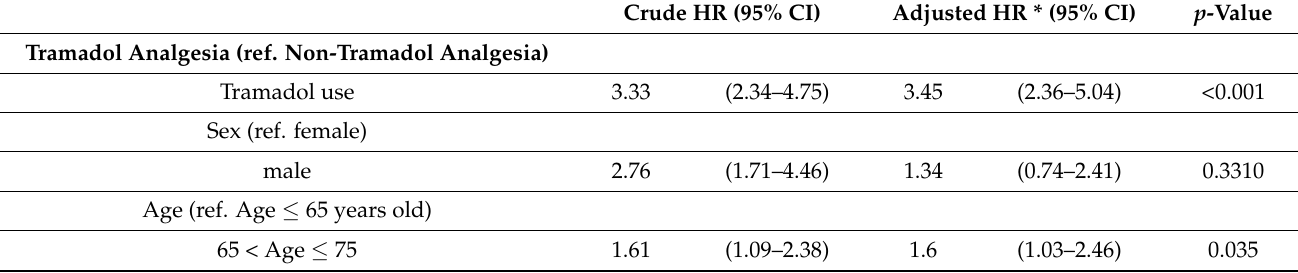
Table 2. Cox proportional models of all-cause death for propensity scores matching chronic pain patients with breast